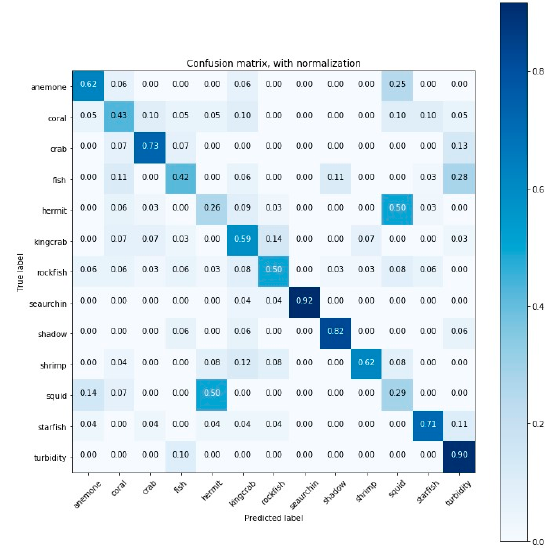
Figure A1. Confusion matrix for the classification results (accuracy) obtained by linear support vector machine (SVM).